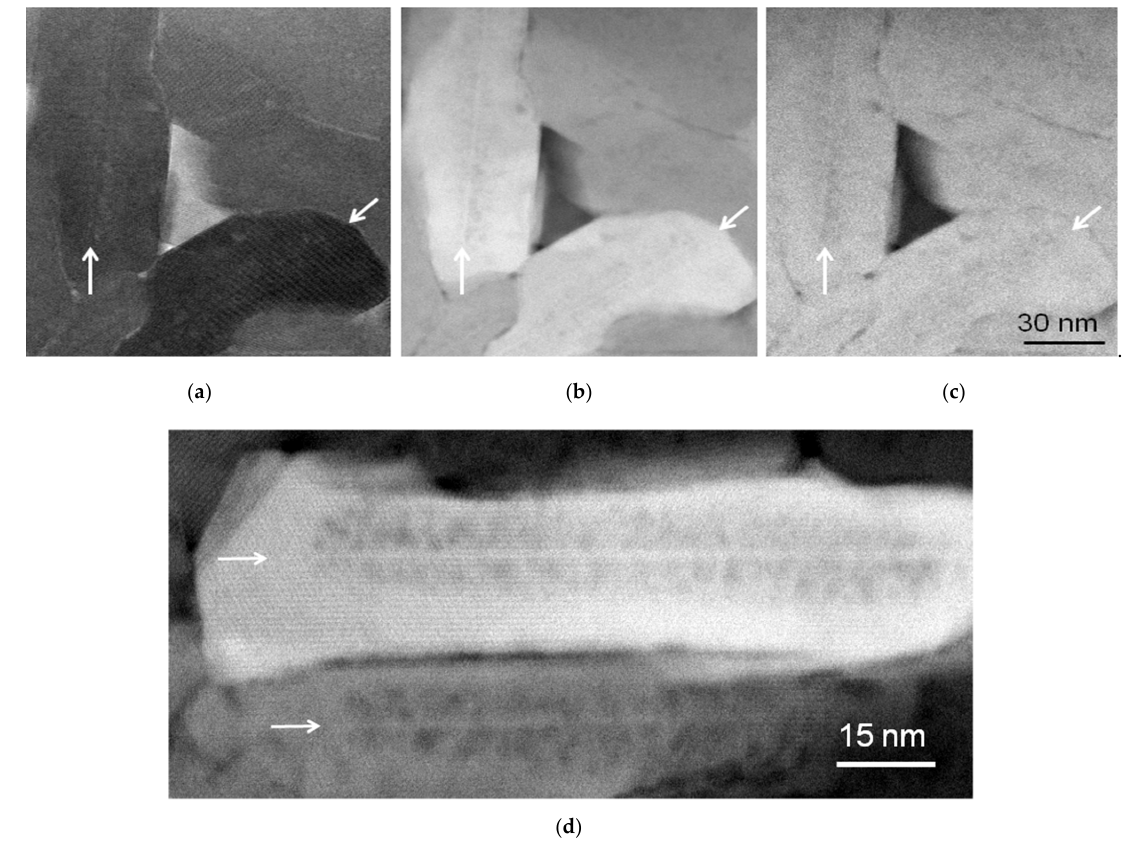
Figure 3. Scanning transmission electron microscopy (TEM) images of the human tooth enamel crystals. ( a ) STEM-bright-field (BF) image; ( b ) STEM-angular dark-field (ADF) image; ( c ) STEM-high-angle angular dark-field (HAADF) image. Note the CDL contrast in each case; ( d ) magnified ADF-STEM image of one of the human tooth enamel crystals where the dark contrast around the CDL indicates a region of strain. The arrows indicate the CDL positions. The electron diffraction patterns (EDPs) of human tooth enamel crystals indicated a